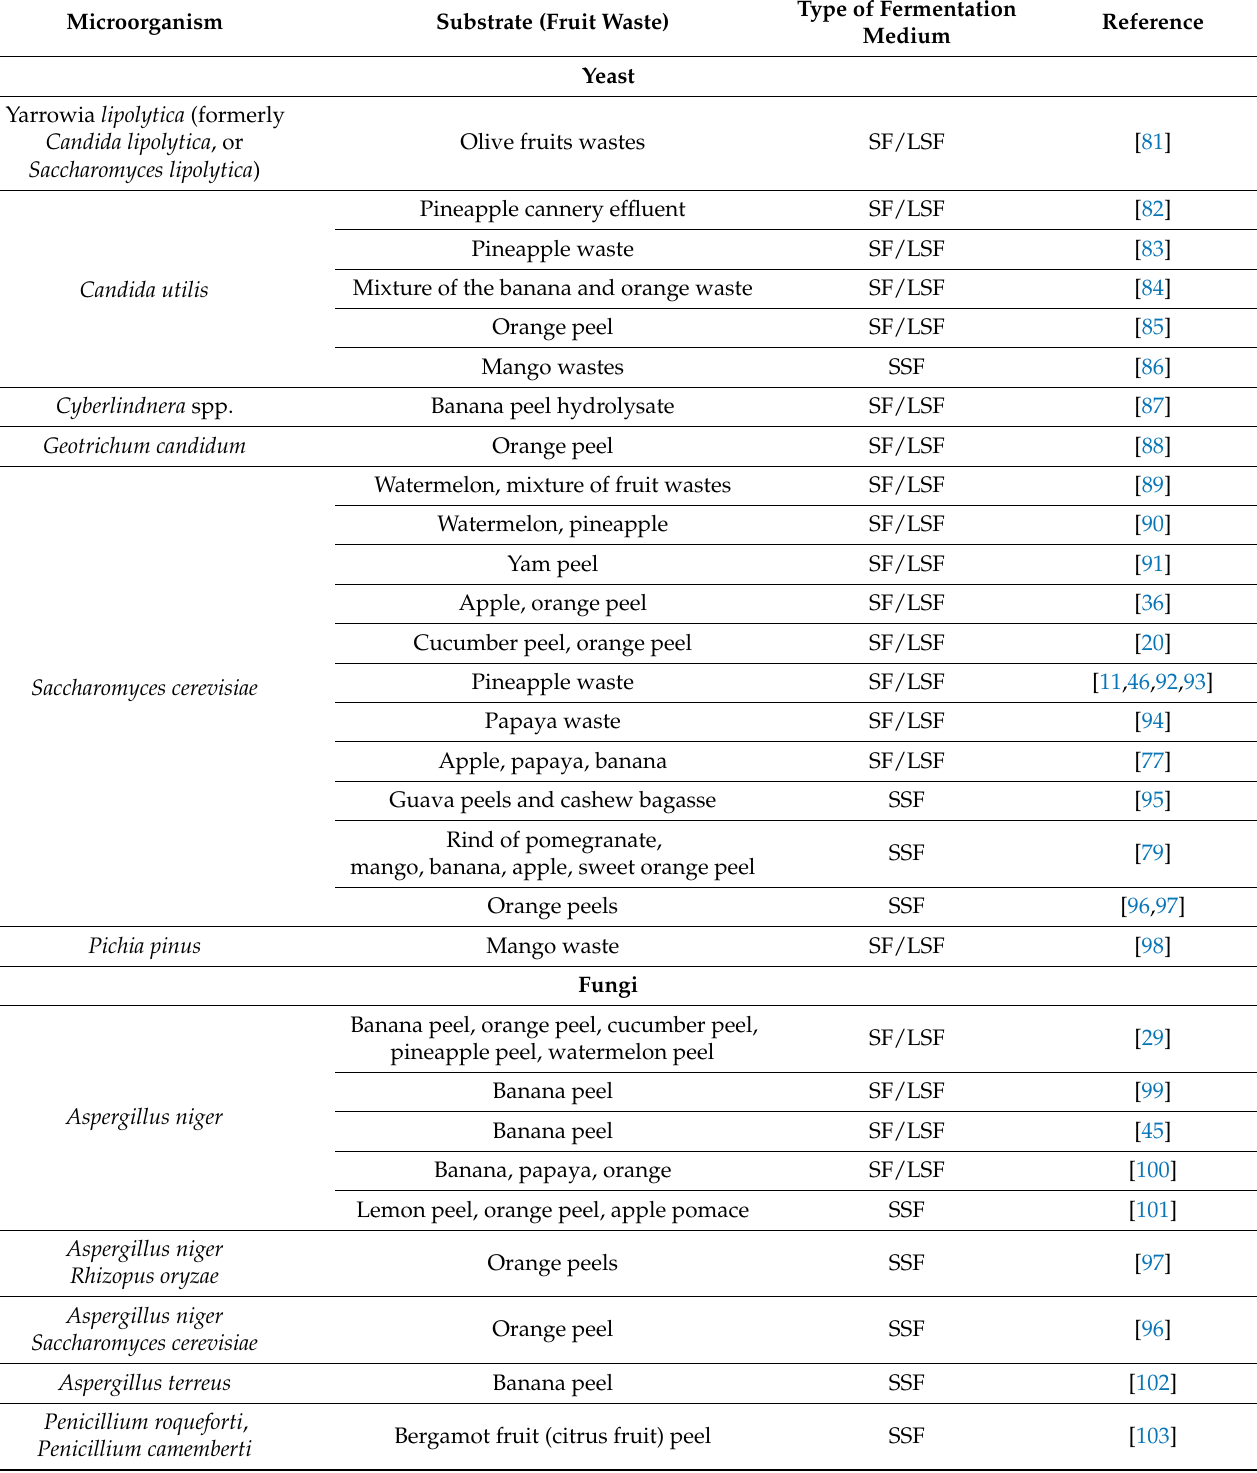
Table 2. SCP production using various microorganisms and fruit wastes as a